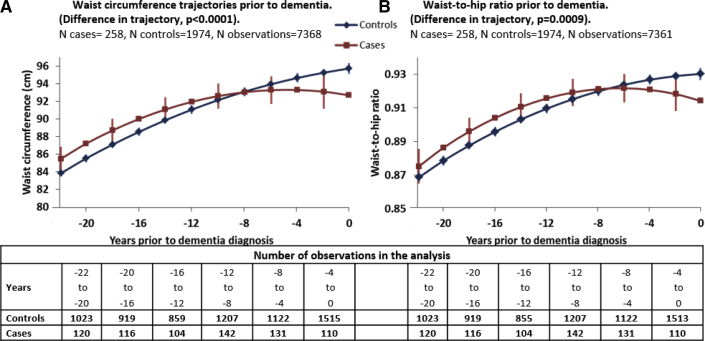
Trajectories of waist circumference (A) and waist-to-hip ratio (B) in the 22 years before dementia. Note: (1) The figure represents marginal effects of dementia on trajectories of waist circumference and waist-to-hip ratio, adjusted for age, sex, and education. Mean number of observations per participant is 2.8 for cases and 3.4 for control subjects. (2) Confidence intervals are presented for alternate time points for ease of presentation. (3) Estimated differences in BMI at each time point are presented in Supplementary Table 4.